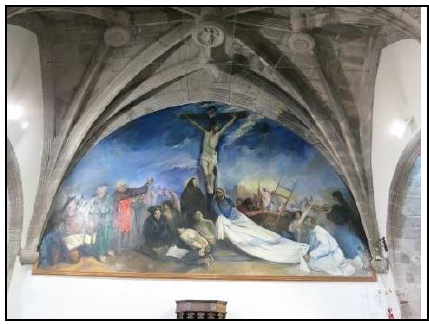
Figure 5. Presbytery before plaster removal